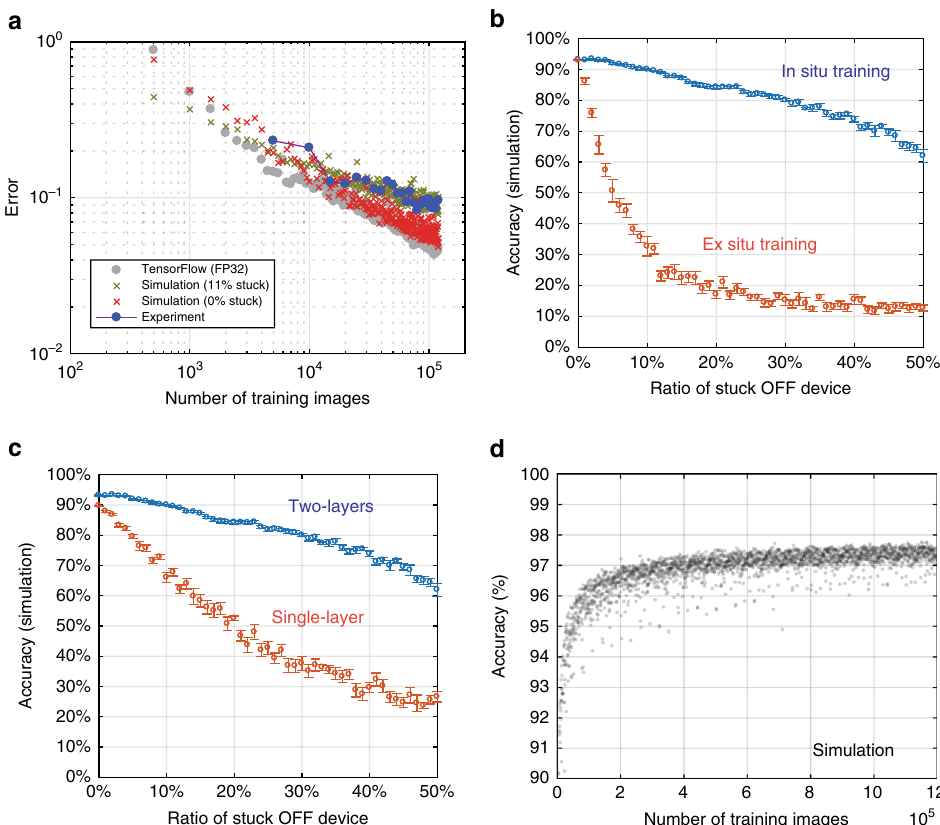
Fig. 4 Analysis based on experimental-calibrated simulation. a The experimental classi fi cation error (accuracy shown in Supplementary Fig. 10) matches the simulated accuracy. The simulation considers experiment parameters, including 11% devices stuck at 10 μ S, 2% conductance update variation, limited conductance dynamic range, etc. The simulation on defect-free assumption shows an accuracy approaching that from TensorFlow. Each data point is the classi fi cation error rate on the complete testing set (10 000 images) after 500 images (simulation or TensorFlow) or 5000 images (experiment). b